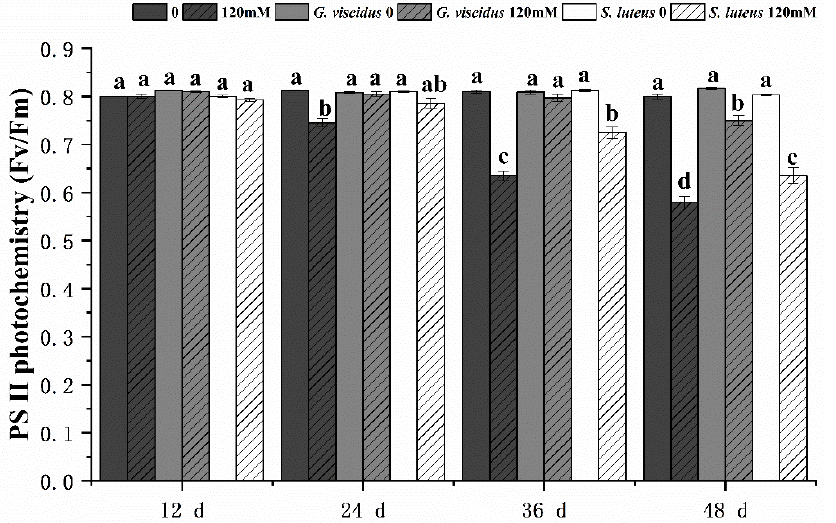
Figure 6. Changes in PSII photochemistry (Fv/Fm) in ectomycorrhizal seedlings of Q. mongolica under NaCl stress. Bars represent means of five replicates ( ± SD). For each parameter, bars with different letters indicate significant differences among treatments, p ≤ 0.05, following one-way ANOVA.